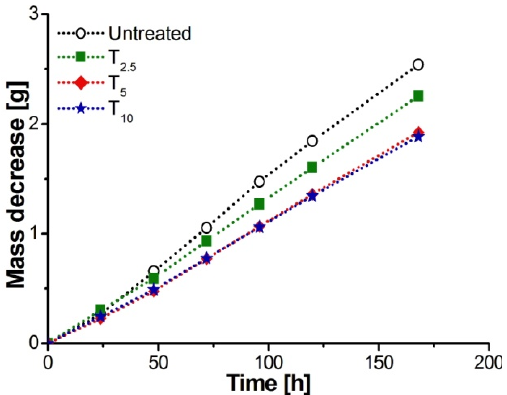
Figure 6. Mass decrease, as a function of time, measured during the water vapour permeability test.